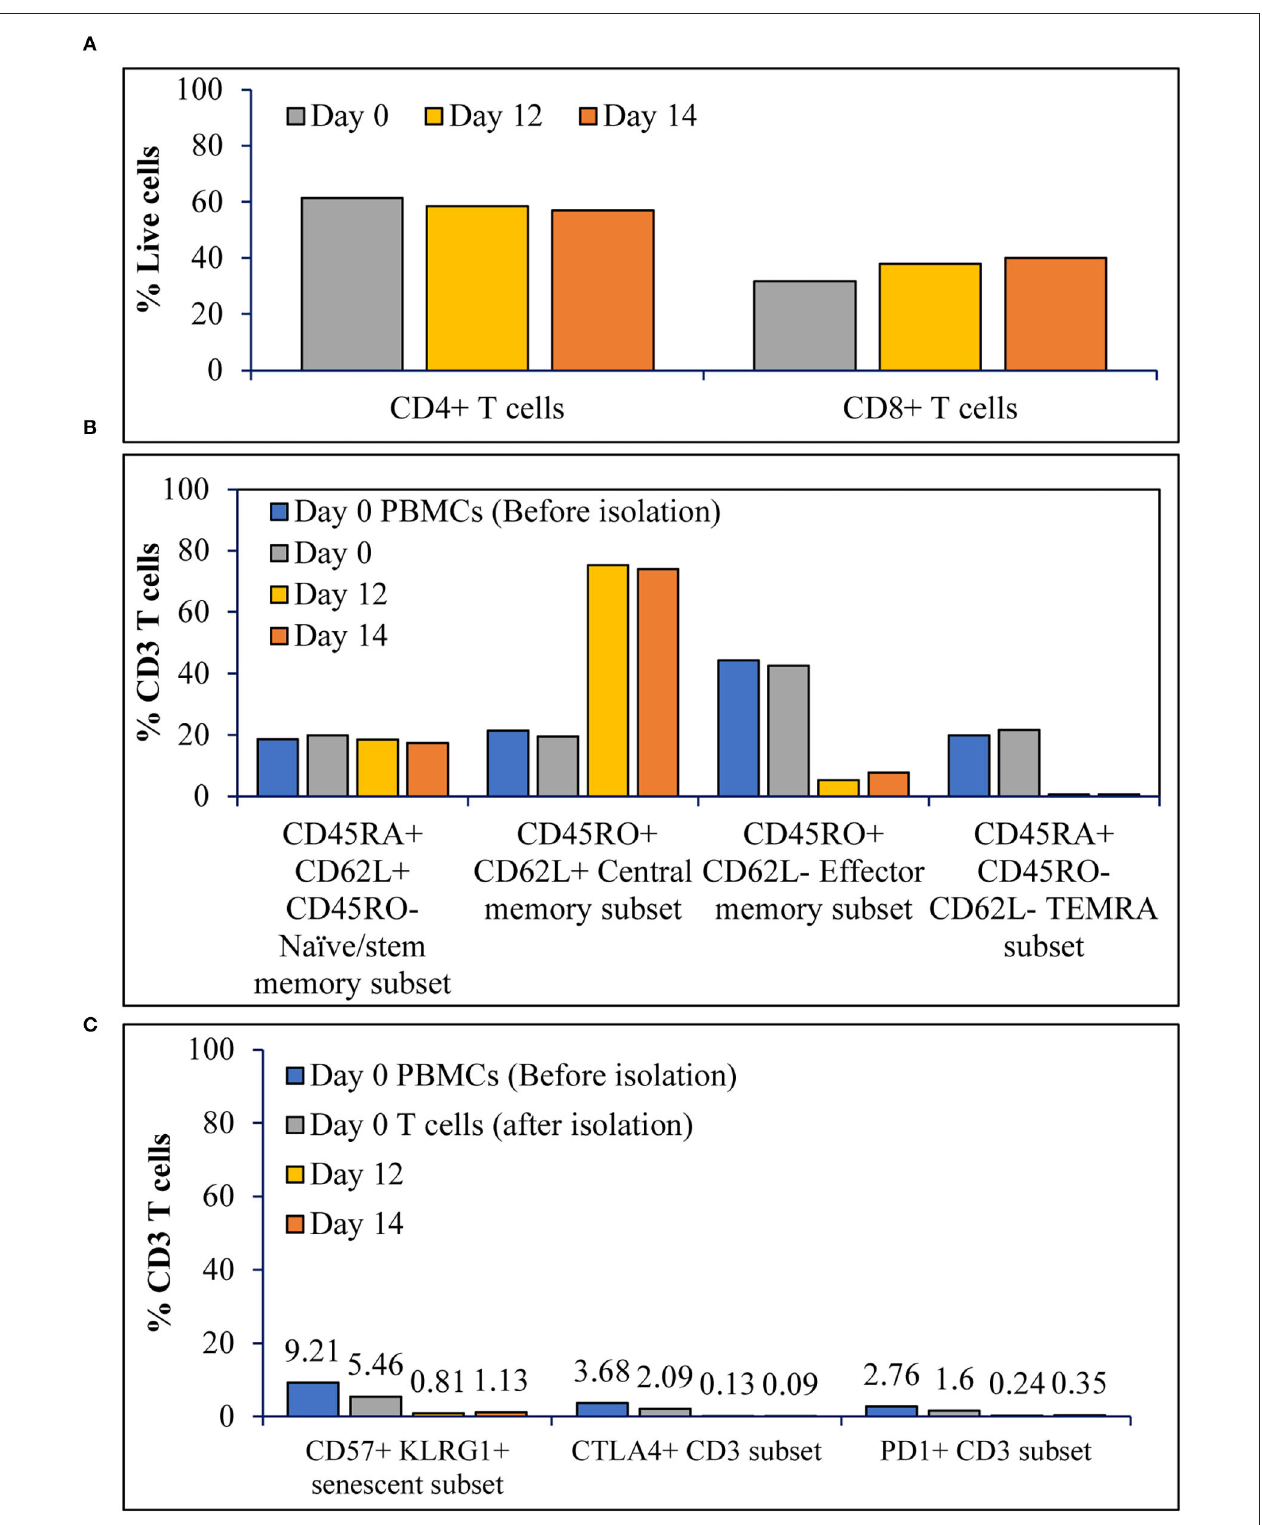
FIGURE 3 | The T cell activation in STR with ATF mediated continuous perfusion results in T cells with stemness over terminal differentiation or exhaustion: (A) Prominent subsets of T cells before, during and after expansion; (B) Differentiation status of T cells before, during and after expansion; and (C) Senescence and exhaustion of T cells before, during and after expansion. The values represent average of 50,000 single cells per condition.